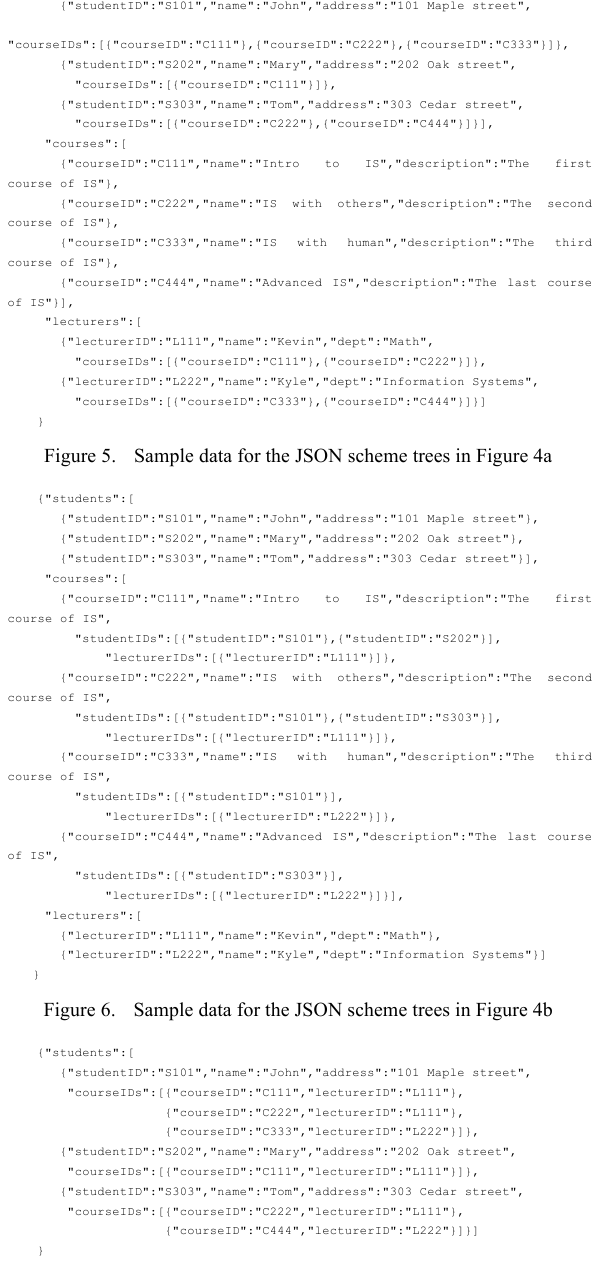
Figure 6. Sample data for the JSON scheme trees in Figure 4b